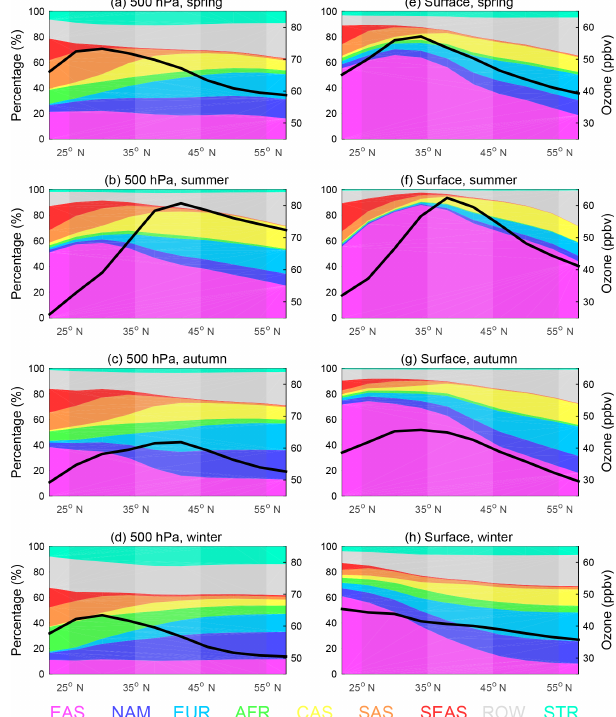
Figure 10. Latitudinal variations in the fractional contributions (in %, left y axis) of native and foreign ozone to ozone in East Asia in the middle troposphere (500hPa) ( a – d ) and at the surface ( e – h ) in 2005. The black lines indicate ozone concentrations averaged over East Asia (in ppbv, right y axis). The abbreviations are for East Asia (EAS), North America (NAM), Europe (EUR), Africa (AFR), central Asia (CAS), South Asia (SAS), South-east Asia (SEAS), the rest of the world (ROW), and the stratosphere